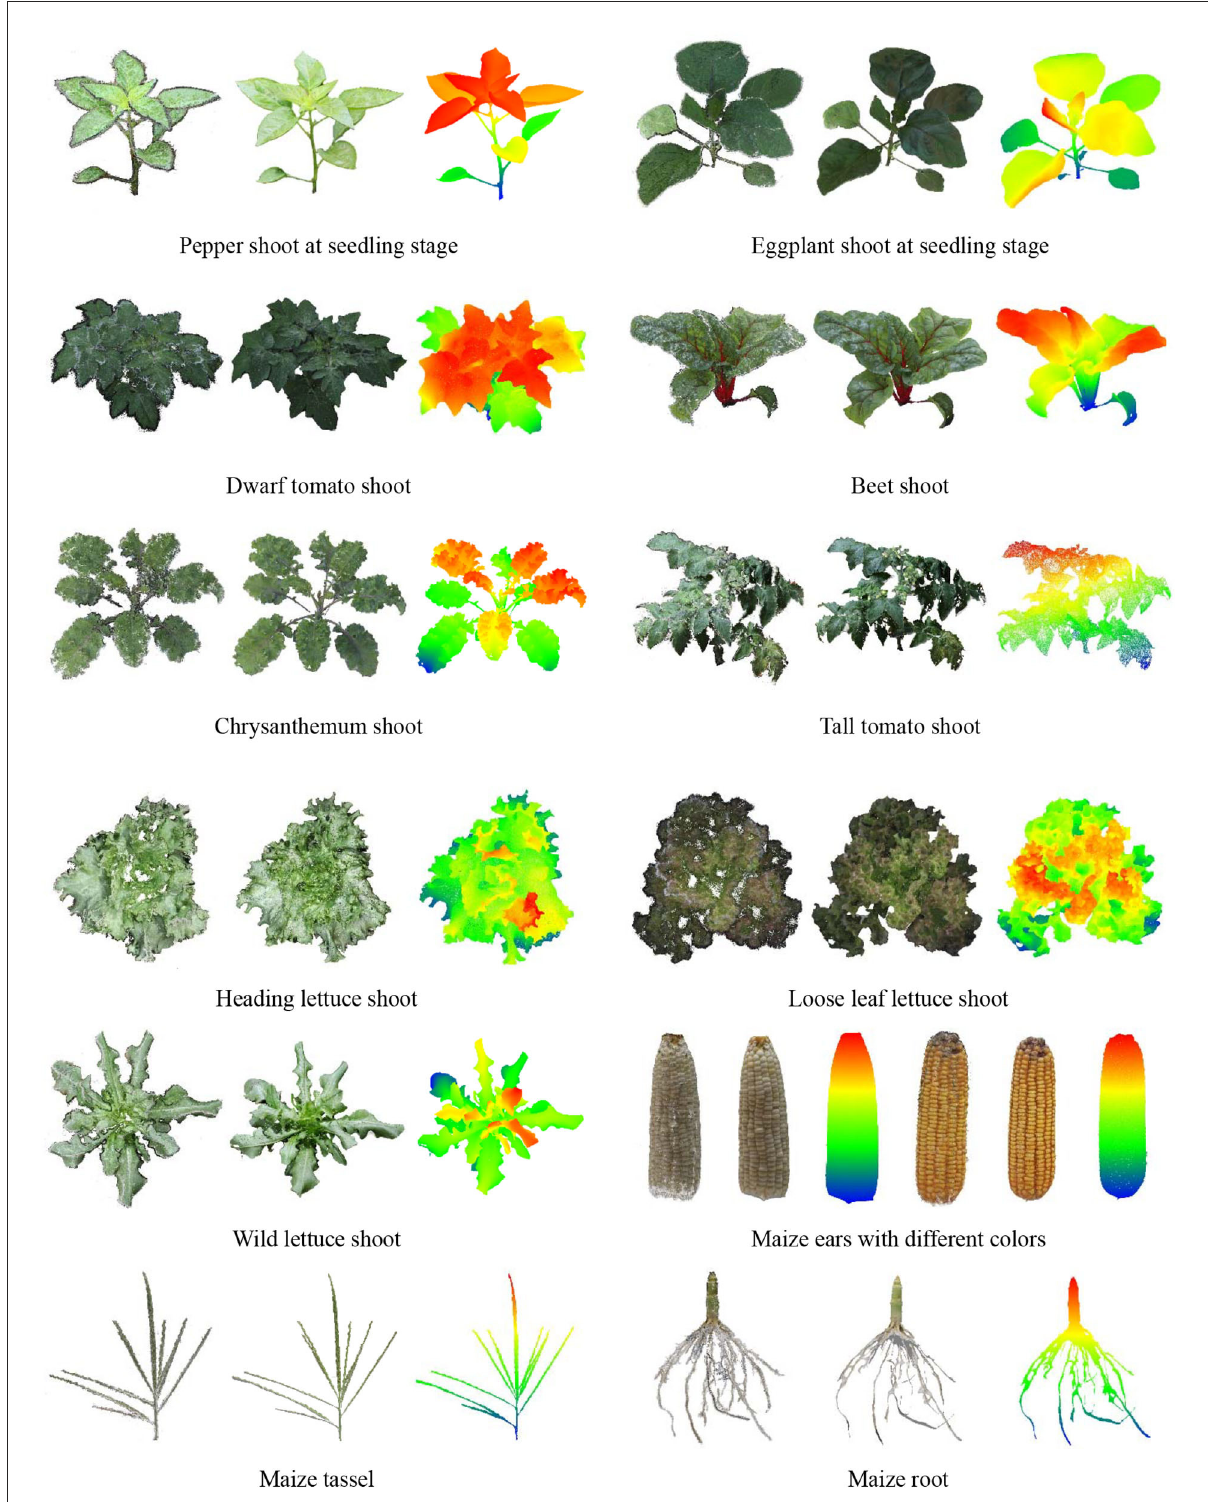
FIGURE11 Point cloud visualization of other plants and plant organs. The left ones were reconstructed using open-source 3D reconstruction program integrated into MVS-Pheno V2. The middle ones were reconstructed using ContextCapture software. The left and middle point clouds were visualized using vertex colors for each group, and the right ones were visualized using color differences along with the height direction of the middle point